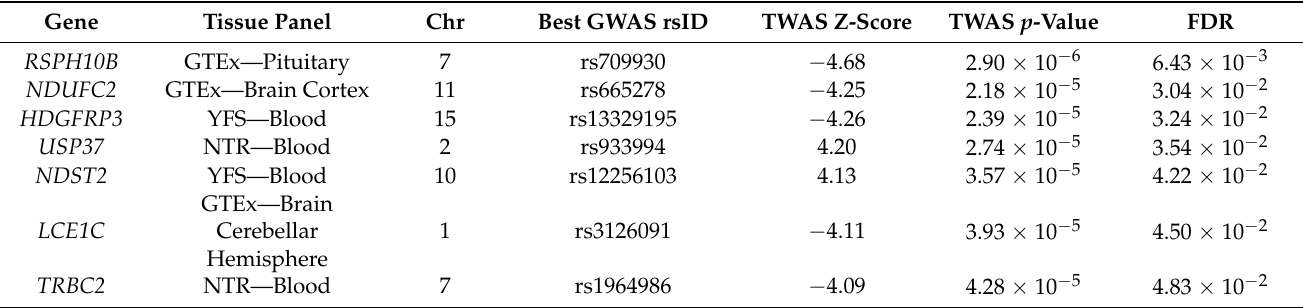
Figure 2. Manhattan plot of TWAS associations between gene expression and ALS. Each dot represents a TWAS signal. The x-axis corresponds to the chromosomal position of the genes and the y-axis corresponds to the Z-score value representing the predicted expression level of each gene in ALS. Black dashed lines indicate the transcriptome-wide significance threshold (FDR < 0.05). The names of statistically significant genes (FDR < 0.05) are labeled on the corresponding dots. Red and blue dots indicate novel risk genes and previously reported genes for ALS, respectively. Table 1. Significant TWAS novel risk genes for ALS (FDR < 0.05). GTEx, Genotype-Tissue Expression project v7; YFS, Young Finns Study; NTR, Netherlands Twin Registry.